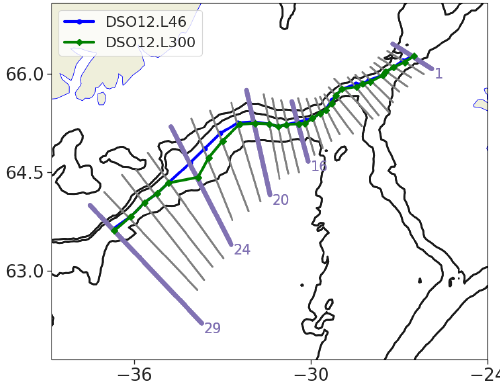
Figure B1. Overflow path. Contours show the 500, 1000, and 2000m depth isobaths. The locations of the various sections used to monitor the model solution are indicated by grey and purple lines. The blue and green dots indicate for each section the loca- tion of the centre of the vein of the DSO in the control simulation (blue, DSO12.L46) and in the 1 / 12 ◦ 300-level simulation (green, DSO12.L300); the blue and green lines show the path of the over- flow in these